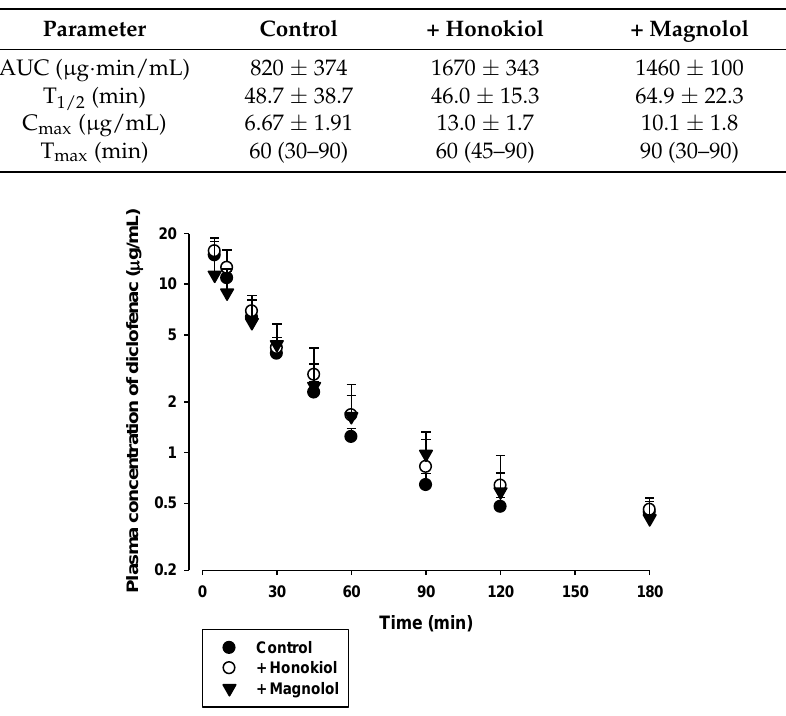
Figure 4. Plasma concentration versus time profiles of diclofenac in rats following its oral administration at a dose of 6 mg/kg without (●) or with 5 mg/kg intravenous honokiol ( ○ ) or magnolol ( ▼ ). The bullet symbols and their error bars represent the means and standard deviations, respectively ( n = 4‒5).